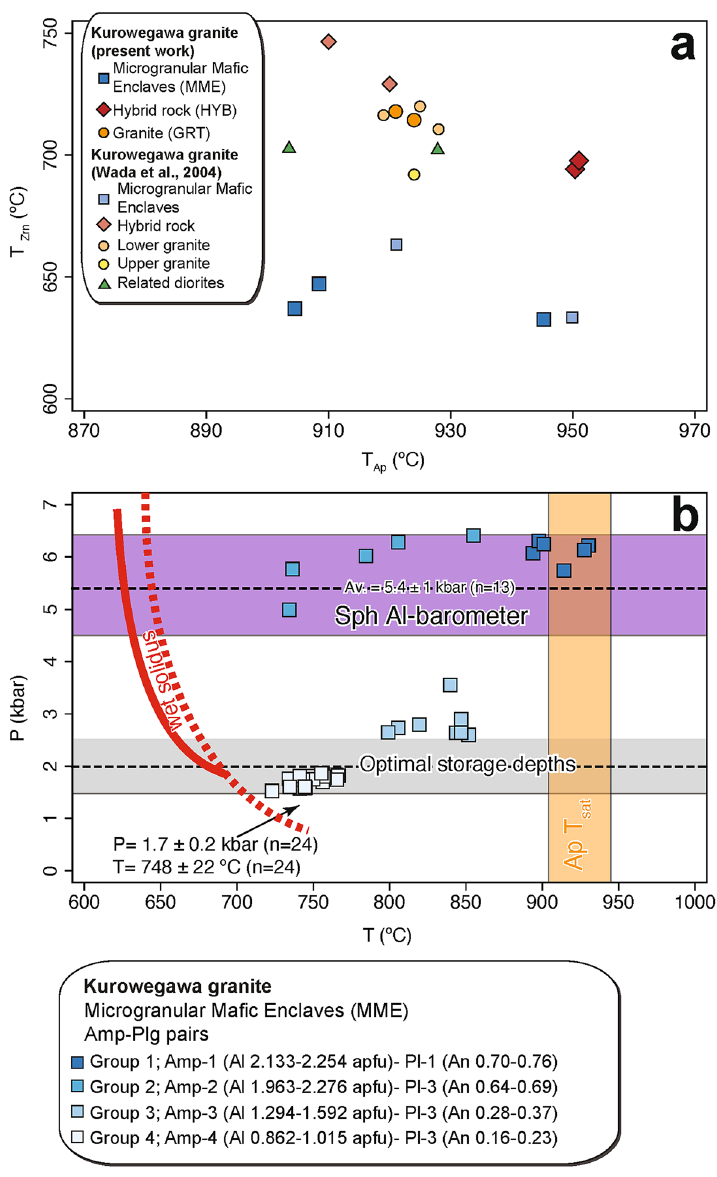
Figure 4. Temperature and pressure estimates for the Kurobegawa Granite. ( a ) Calculated zircon saturation temperature (T Zrn ) vs apatite saturation temperature (T Ap ) using the KRW sample (Fig. 3) and data from Wada et al. 23 ( b ) Pressure vs temperature for various amphibole (Amp)-plagioclase (Pl) pairs in MMEs. We grouped four Amp-Pl pairs based on total Al content (atoms per formula unit: apfu) in Amp and anorthite (An) content in Pl. Temperatures were calculated using the Amp-Pl thermometer of Molina et al. 27 for groups 1 and 2 and Holland and Blundy 28 for groups 3 and 4. Pressures were estimated using the Al in amphibole barometer 29 . The pressure range by the Al in sphene (Sph) barometry 30 and the temperature range by apatite (Ap) saturation thermometry are also plotted. The red dotted line shows the experimentally determined water-saturated solidus for tonalite 31 and the red solid line is the water-saturated solidus calculated using rhyolite-MELTS for diorite 32 . The transparent-grey area represents the proposed optimal emplacement window of shallow magma chambers (P = 2 ± 0.5 kbar), estimated using thermo-mechanical models 33